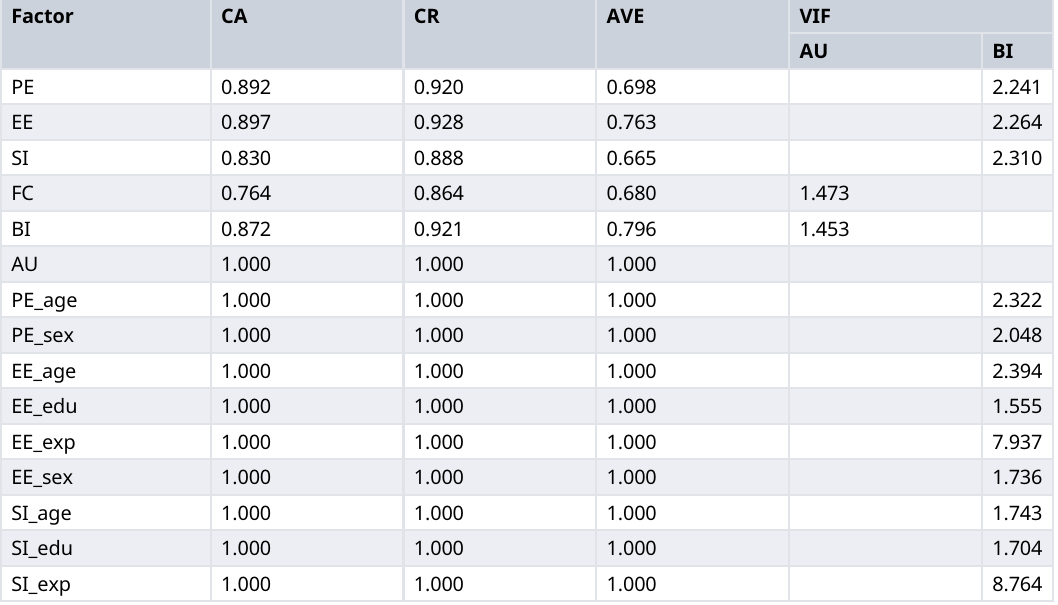
Table 3. The results testing of CA, CR, AVE, dan